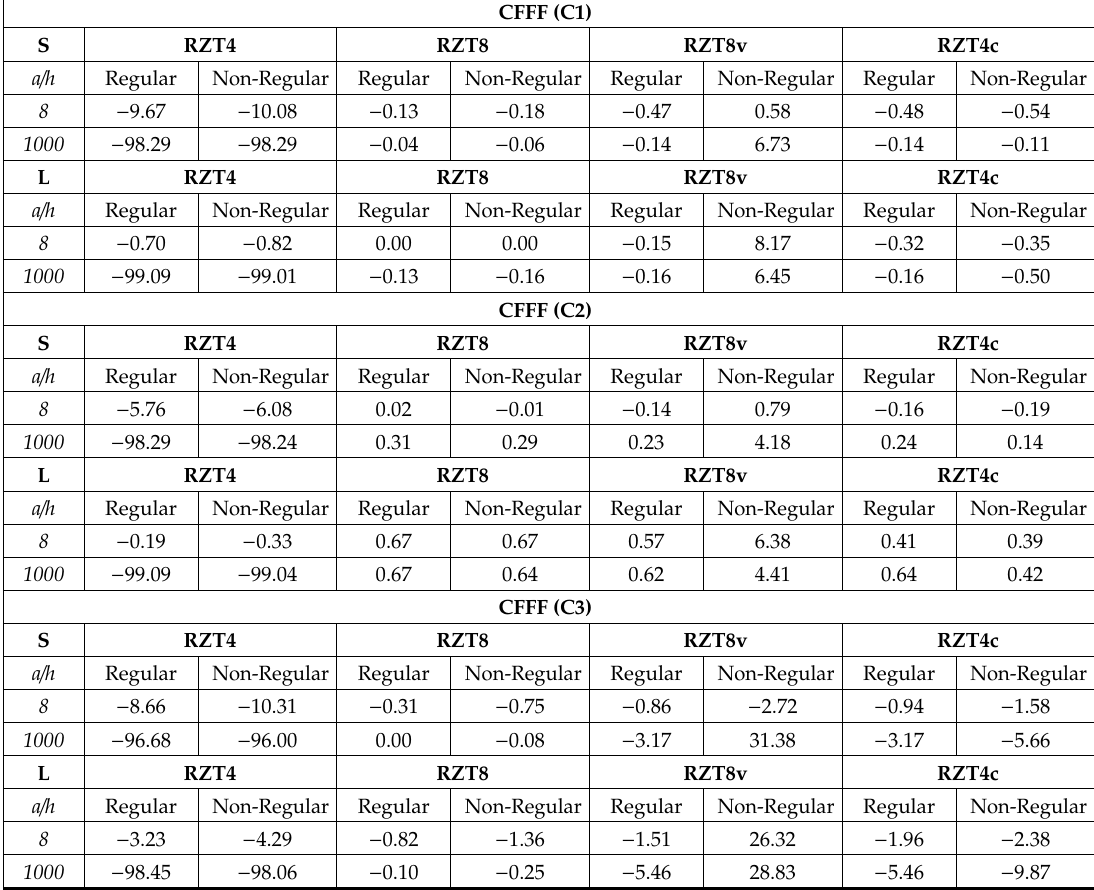
Table 8. Percent errors of FEM results on the maximum deflection of thick ( a / h = 8) and very thin ( a / h = 10 3 ) cantilever square plates under various load distributions. Regular and distorted 16 × 16 mesh (Figure 11). CFFF (C1) RZT4 RZT8